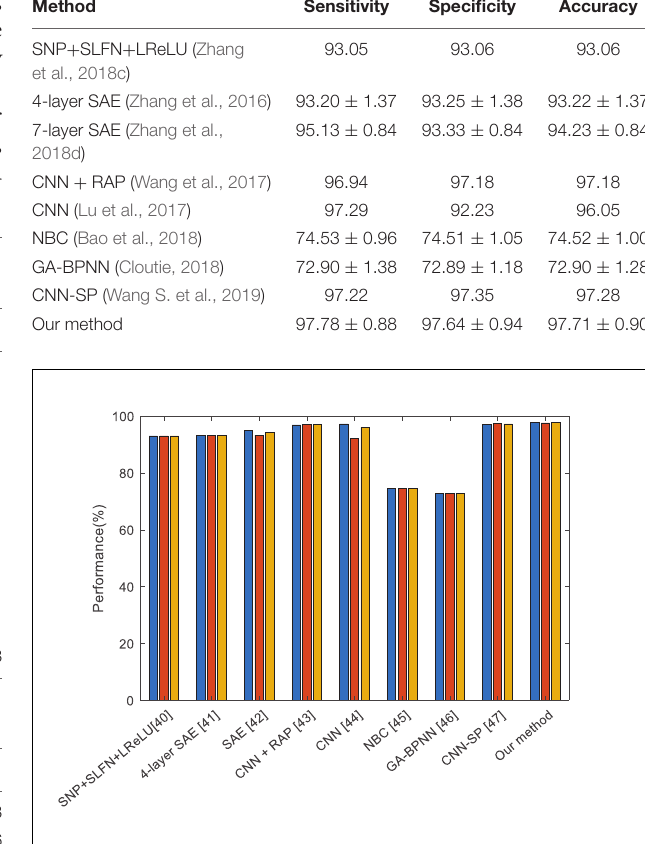
FIGURE 10 | Comparison of the state of art methods (Blue means the sensitivity, red means the specificity, and yellow means the accuracy).